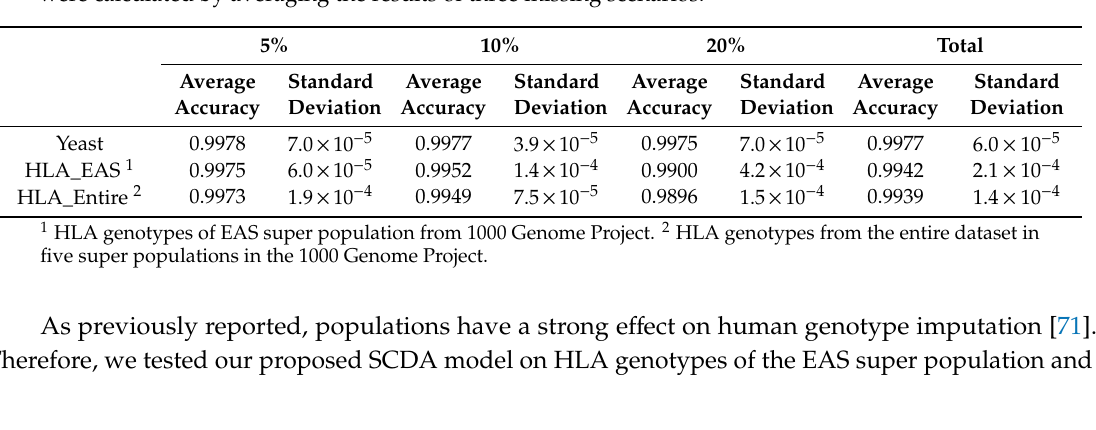
Table 2. Performance comparison in terms of accuracy on yeast and human leukocyte antigen (HLA) genotypes at three missing scenarios. The average accuracy and standard deviation of each imputation method was calculated by running the sparse convolutional denoising autoencoders (SCDA) model 10 times at every missing scenario (5%, 10%, 20%). The overall average and standard deviation values were calculated by averaging the results of three missing